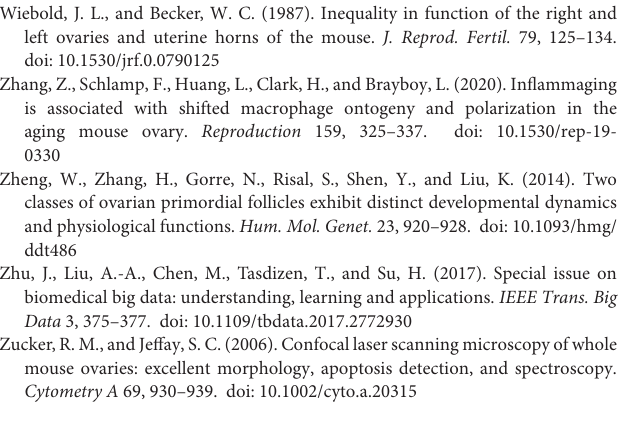
mouse ovaries: excellent morphology, apoptosis detection, and spectroscopy. Cytometry A 69, 930–939. doi: